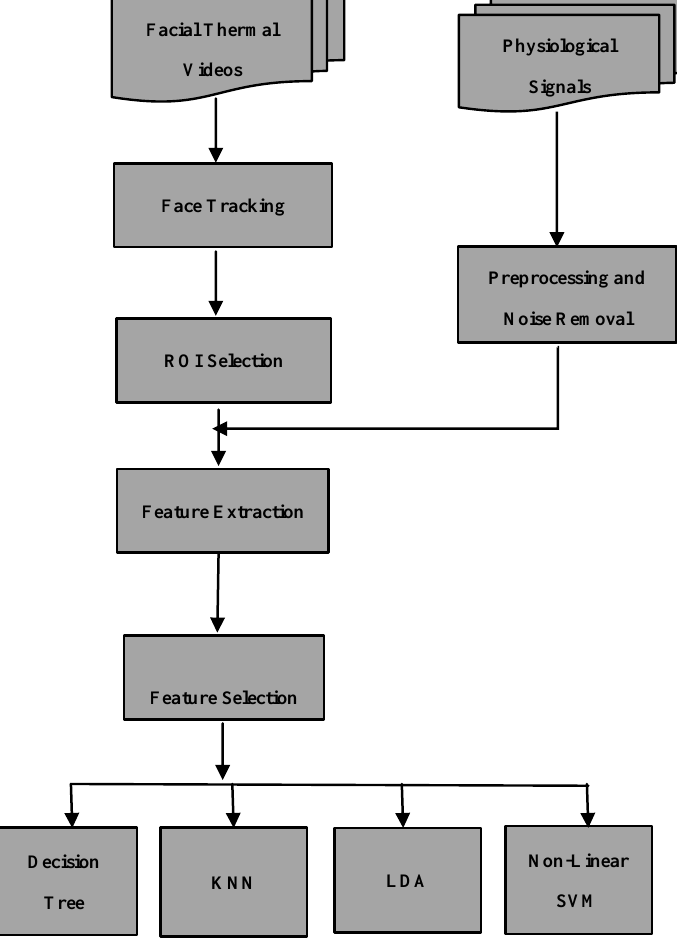
Figure 2. Overview of the methodology in this study.